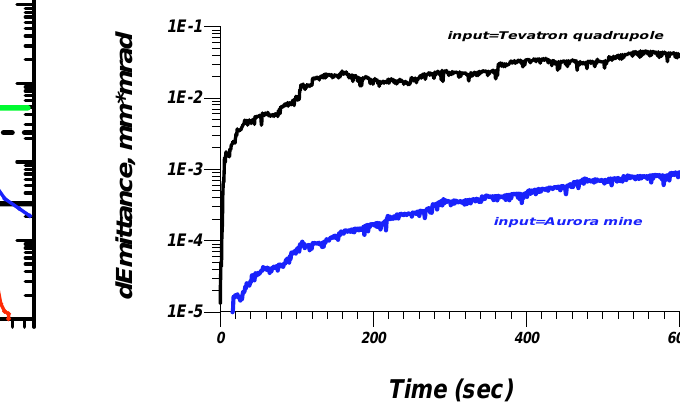
FIG. 19. (Color) The VLHC emittance growth simulations with two data inputs: Tevatron quadrupole vibrations (upper line) and the Aurora mine tunnel (lower line) vibrations as